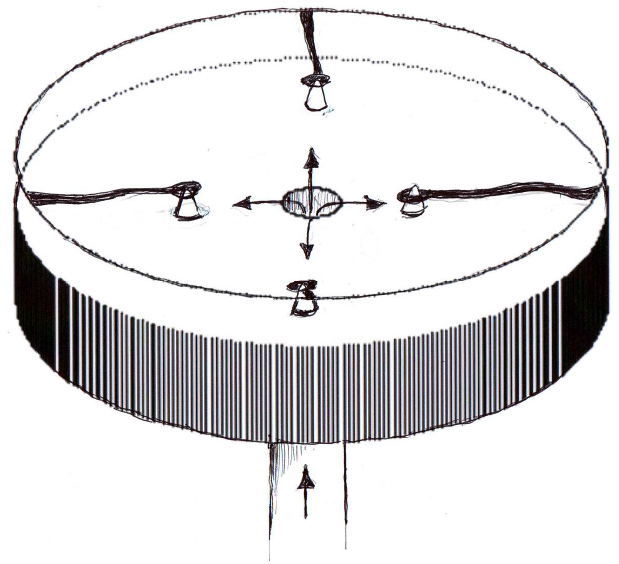
Figure 1. Diagram of stagnation point flow chamber, showing coverslip supported by 4 points. Arrows indicate flow. Areas where flowing plasma had left fibrinogen on the coverslip are shown in